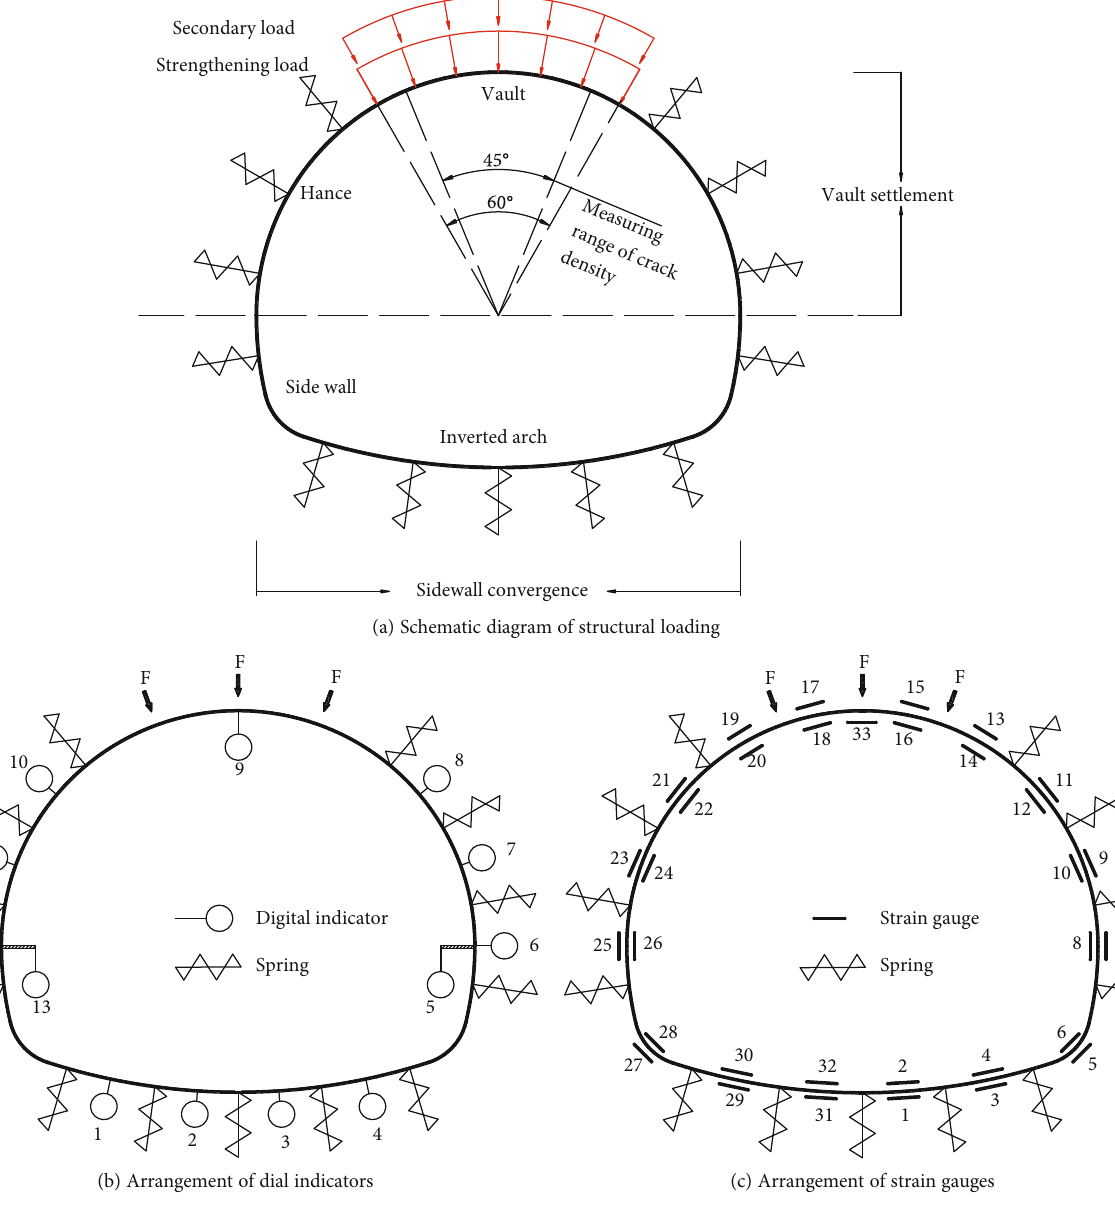
Figure 3: Secondary load simulation and measurement